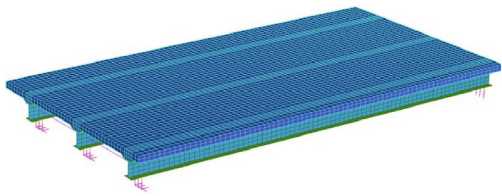
Figure 17: Shell-solid model. Table 4: Updating parameters for sensitivity